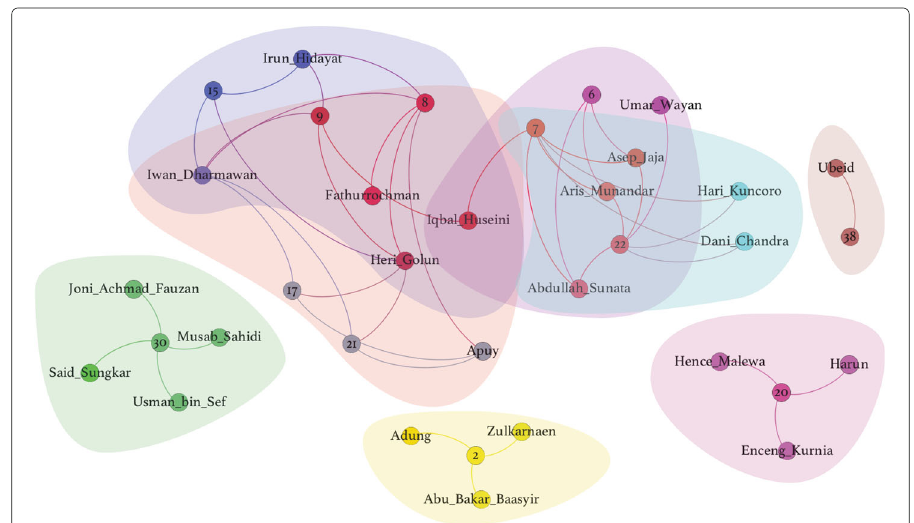
Fig. 4 Almost strong communities found by MaxBic